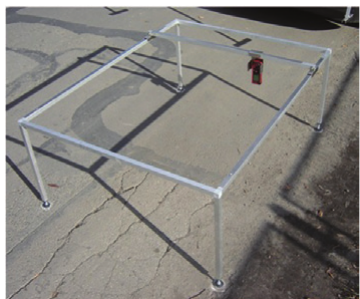
Fig. 5. Reference test-bench with the laser distance